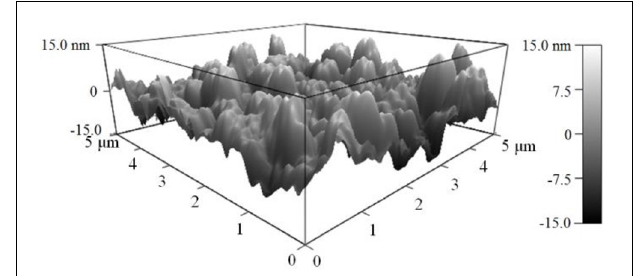
FIGURE 2 | AFM image of the surface (5 × 5 µ m) of NiO nanoparticles thin film on YSZ plate after sintering at 1100 ◦ C.